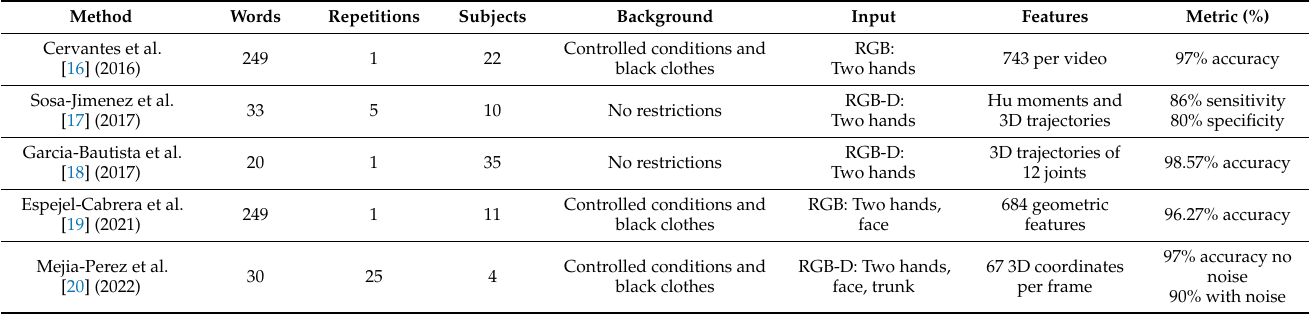
Table 1. Comparison of MSL recognition methods for dynamic signs (words).